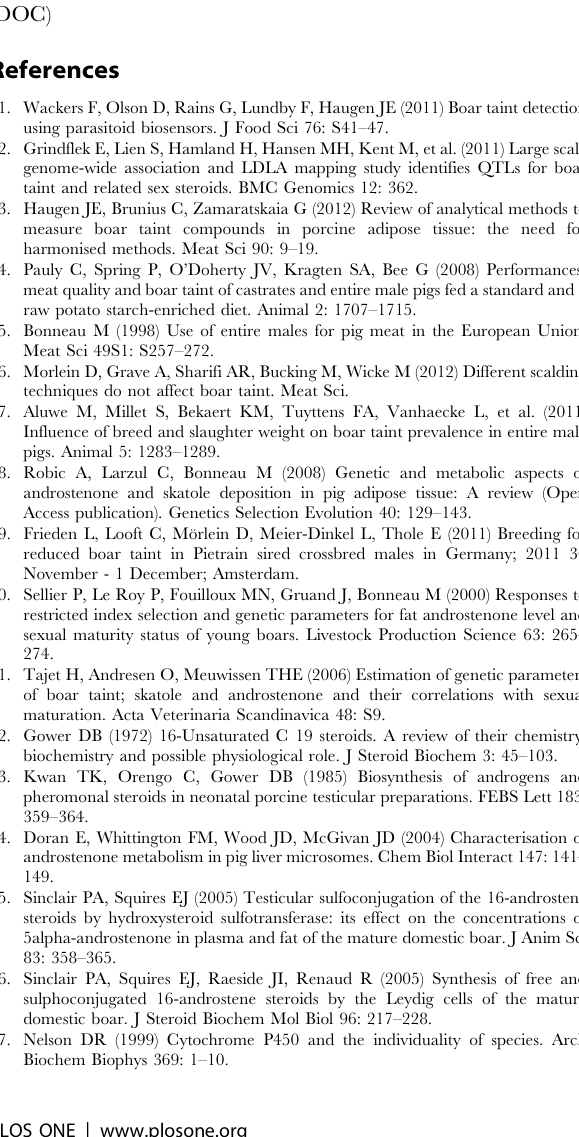
Table S3 Selected SNP detected by RNA-seq that were validated using RFLP. Table S4 Genotype, allele frequencies and the chi- square test of selected SNPs validated using